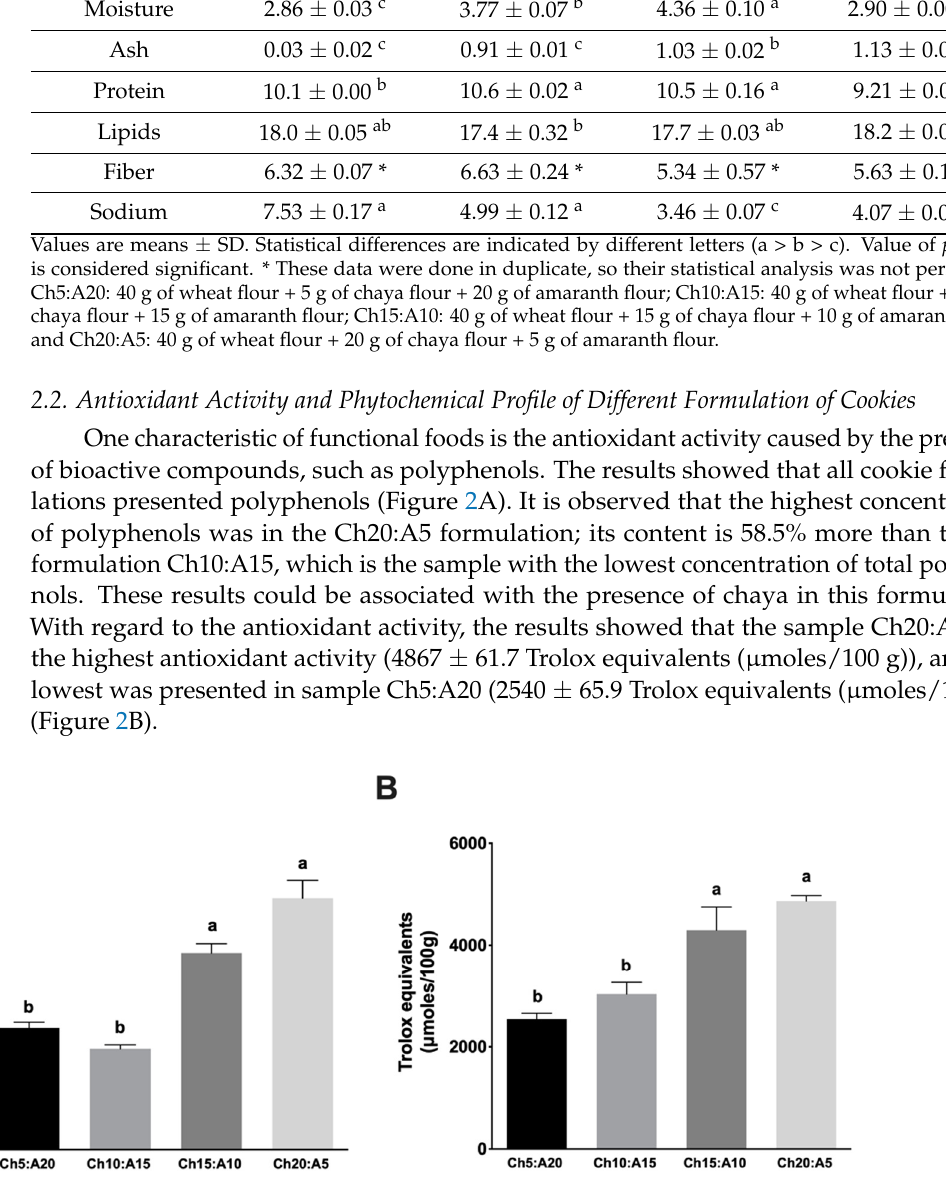
Table 1. Chemical composition of different formulations of cookies. Data are presented as g in 100 g. Component Moisture